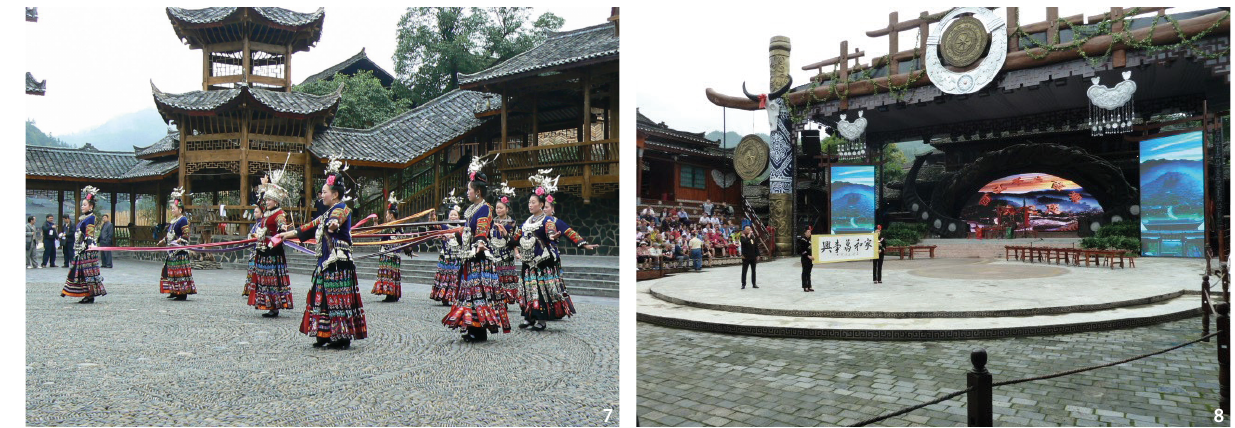
Figure 7 Xijiang Miao Village performance area 2008 (Source: the author). Figure 8 Xijiang Miao Village performance arena 2017 (Source: the